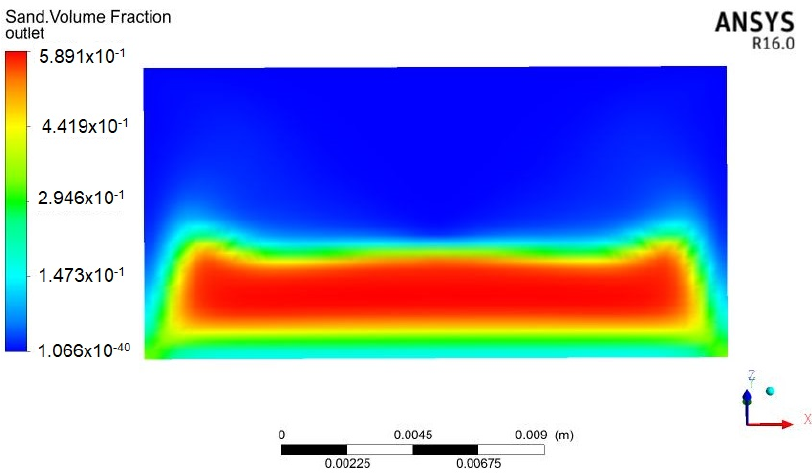
Figure 10. Sand volume fraction at the outlet.